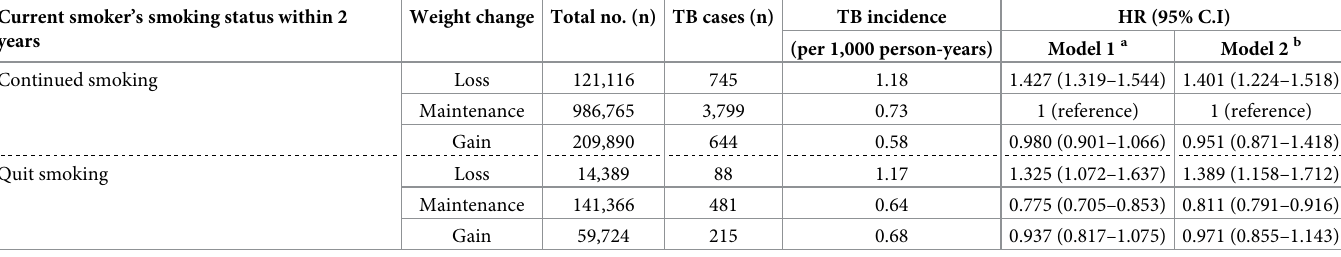
Table 5. Incidence and risk of tuberculosis according to changes in smoking status and body weight among current smokers. Current smoker’s smoking status within 2